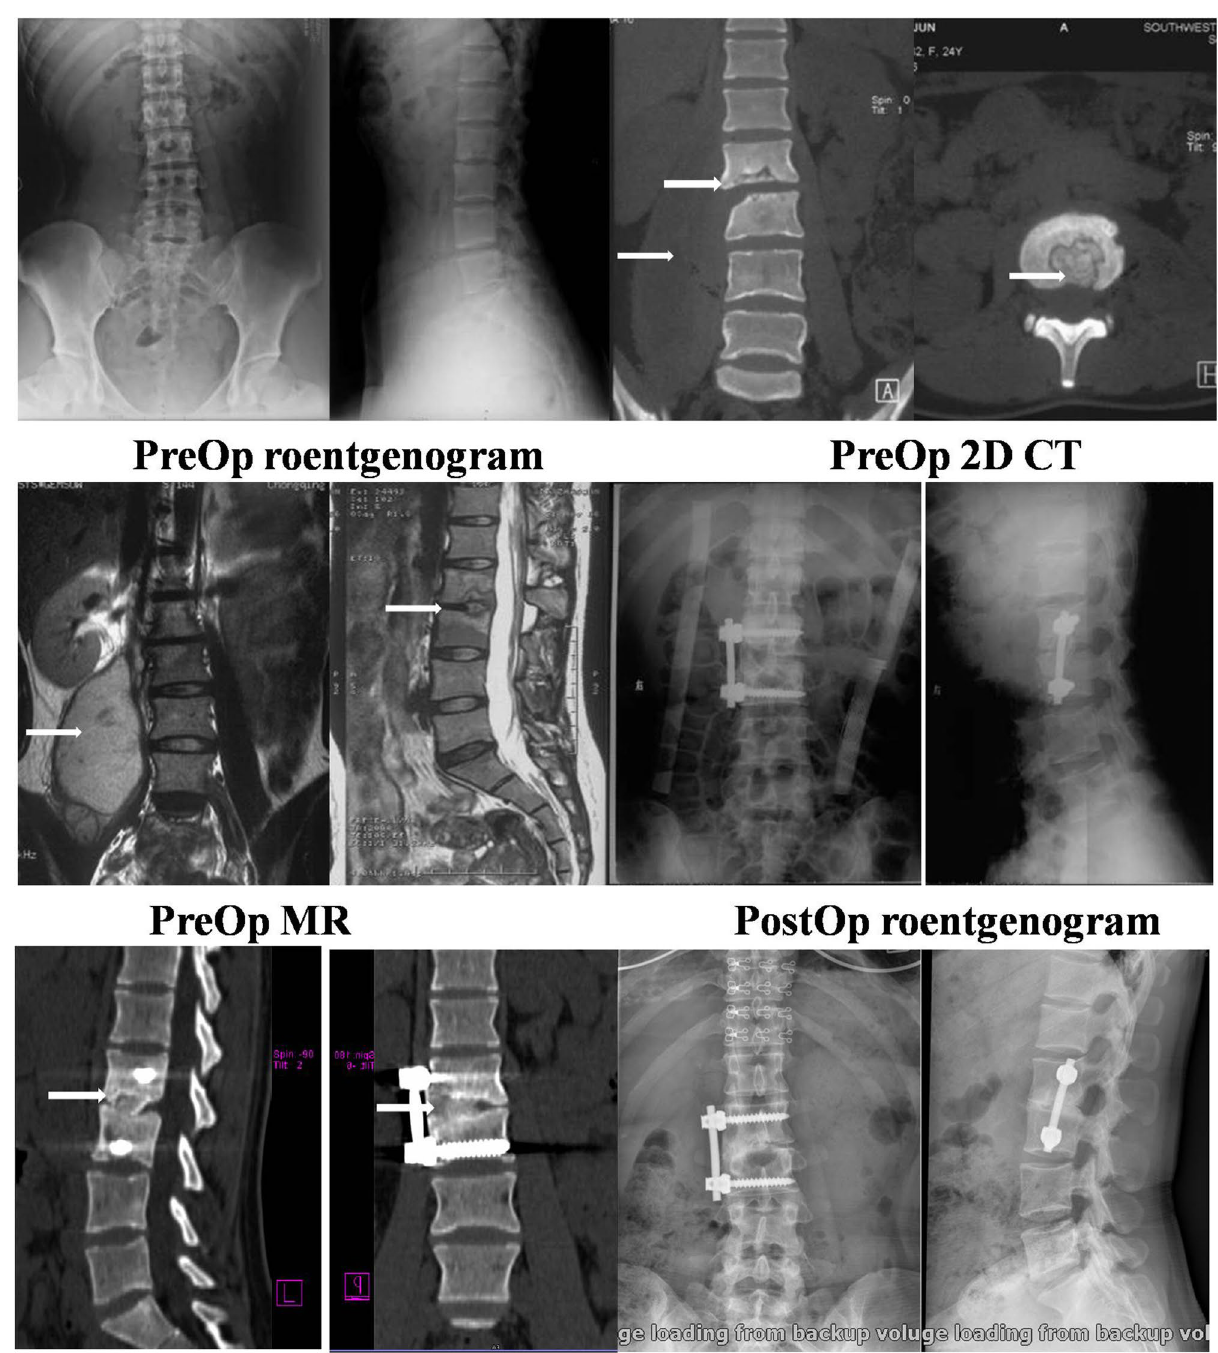
Figure 3. A 25-year-old woman complained of severe back pain. The preoperative roentgenogram, 2D CT scan and MRI scan showed destruction of L2/3 vertebral bodies and right psoas abscess (white arrows). The immediate postoperative roentgenogram showed the tricortical iliac crest allograft and anterolateral single rod instrumentation. The 2D CT scan taken at the 2-year follow-up showed good incorporation and normal lordosis. The roentgenogram taken at the 9-year follow-up showed that solid bony fusion was achieved, and the loss of correction was